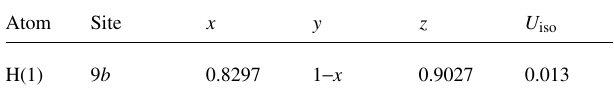
Table 2. Atomic coordinates and displacement parameters (in Å 2 ) .